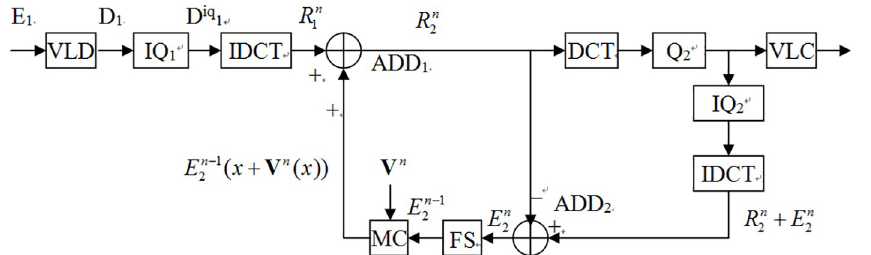
Fig 3. Simplified architecture using the correlation between R n